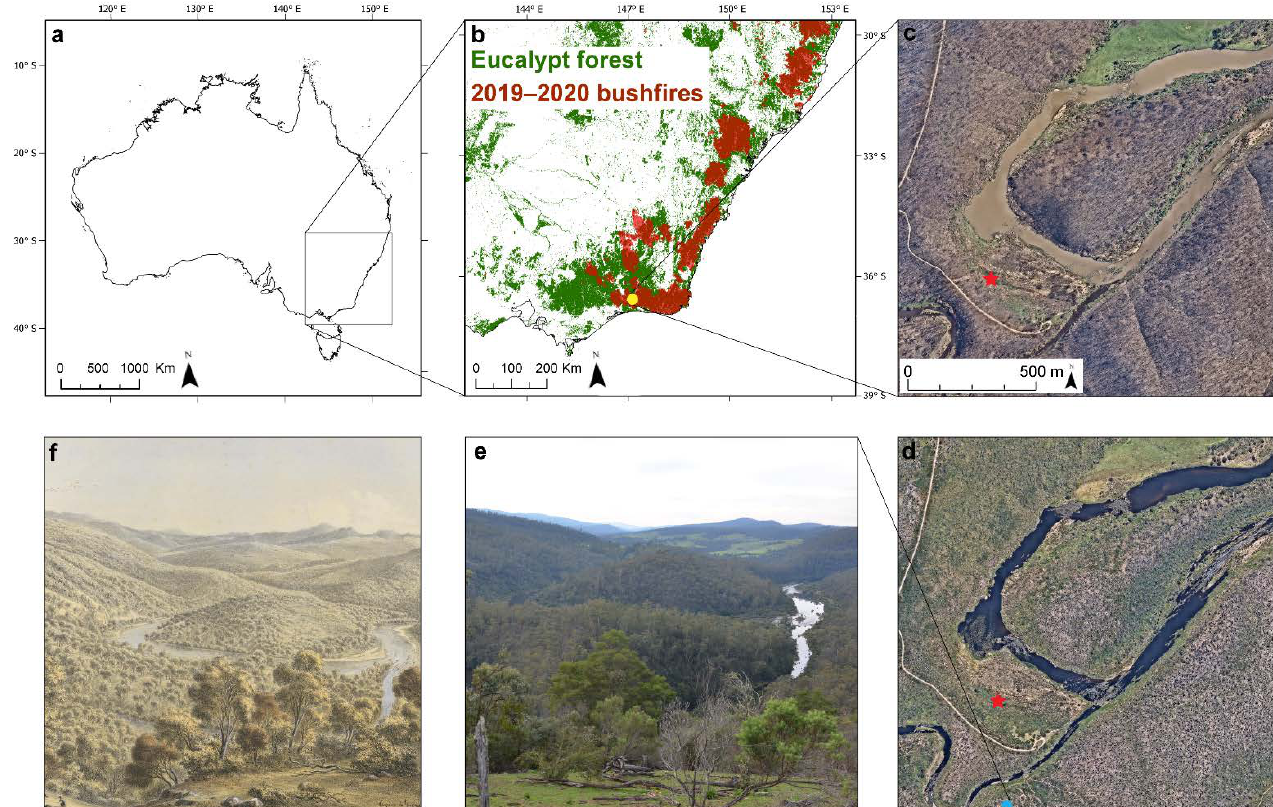
Figure 1. ( a ) Map of Australia, black square indicates study region; ( b ) Southeast Australia study region with Eucalypt forests (green) [58], the 2019–2020 Black Summer bushfires burn area (red) [59] and the location of the site (yellow dot); ( c ) Satellite image of the confluence of the Snowy and Buchan Rivers and the study site (red star) after the Black Summer bushfires (taken 27th February 2020; [60]); ( d ) Satellite image of the confluence of the Snowy and Buchan Rivers and the study site (red star) with forest recovering (taken 14th December 2020; [60]); ( e ) Photograph of Junction of the Buchan and Snowy Rivers taken by Professor Bruno David (taken 2019, shortly before the 2019–2020 bushfires); ( f ) Junction of the Buchan and Snowy Rivers, Gippsland (painted in 1867) colour lithograph, Eug è ne von Gu é rard [61]. For interpretation of the references to colour in this figure, the reader is referred to the online version of this